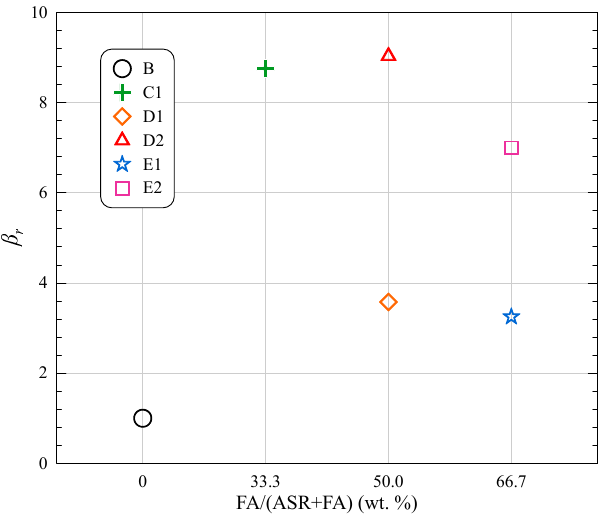
Figure 17. Simultaneous analysis of expansion ratio and compressive strength.